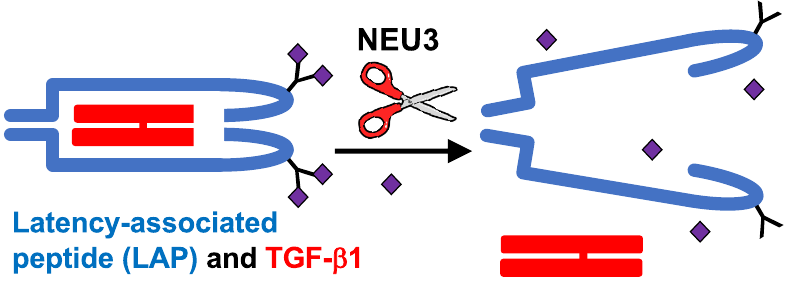
Figure 2. Summary of the NEU3 → TGF- β1 pathway in Figure 1. NEU3 removes sialic acids (purple diamonds) from the LAP protein (blue) that sequesters TGF- β1 (red) in the extracellular environ- diamonds) from the LAP protein (blue) that sequesters TGF- β 1 (red) in the extracellular environment, ment, causing the LAP to release active TGF- β1. causing the LAP to release active TGF- β